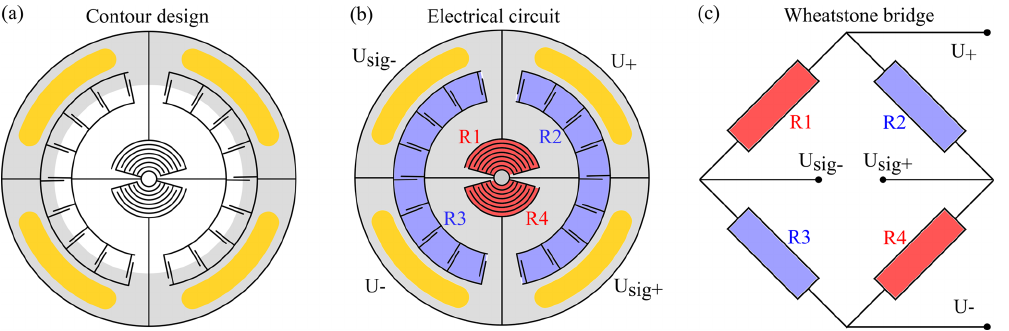
Figure 4. (a) Contour design of the Wheatstone bridge for the laser-based patterning. The bright inner zone represents the 300µm thick membrane and the yellow areas highlight the solder pads, consisting of the multilayer thin film. (b, c) The electrical circuit (Wheatstone bridge) is generated by laser cutting the sensor layer along the black lines (blue areas: resistors R2, R3 measuring negative strain; red areas: resistors R1, R4 measuring positive